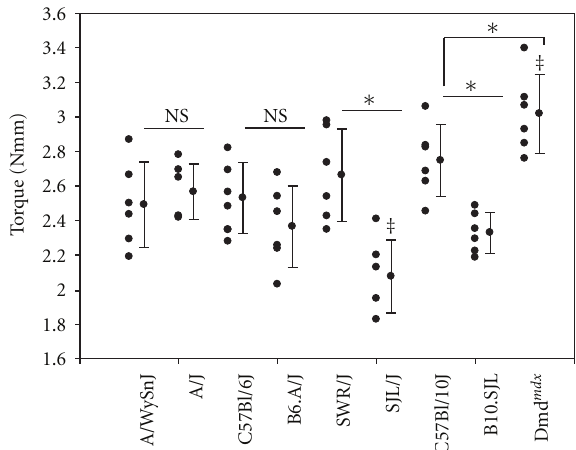
Figure 1: Baseline torque before large-strain injury. Maximum iso- metric tetanic torque of the dorsiflexor muscle group was measured prior to LSI. All control strains (A/WySnJ, C57Bl/6J, SWR/J, and C57Bl10/J) produced a similar level of contractile torque. Among the Dysf mutants, only SJL/J mice and B10.SJL mice were weaker than their corresponding controls. SJL/J mice were also weaker than A/J mice. Raw torque produced by DMD mdx was the highest among the studied strains of mice. ∗ Significant di ff erence compared to control strain at same time point. NS:no significant di ff erence. ‡ Significant di ff erence compared to A/J at same time point.